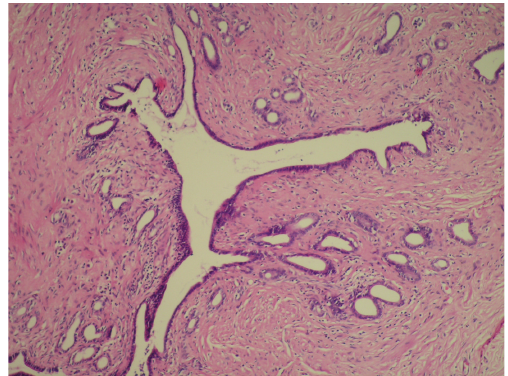
Figure 2: Ductal epithelial and acinar group in a fribrovascular stroma (x100).